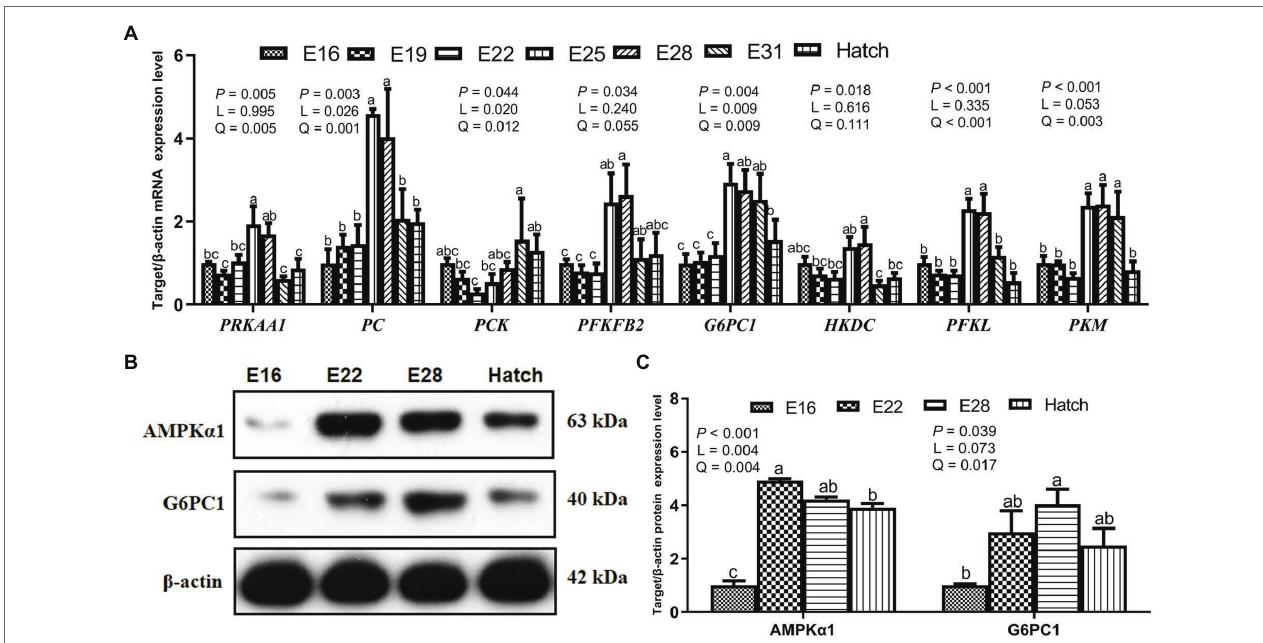
FIGURE 2 | Hepatic gene and protein expression related to glucose metabolism in the avian model. (A) Hepatic gene mRNA relative expression related to glucose metabolism in the avian model; (B,C) The expression of proteins related to glucose metabolism in the liver of avian embryos. PRKAA1 , protein kinase AMP-activated catalytic subunit alpha 1; PC , pyruvate carboxylase; PCK , phosphoenolpyruvate carboxykinase; PFKFB2 , 6-phosphofructo-2-kinase; G6PC1 , glucose-6- phosphatase; HKDC , hexokinase; PFKL , phosphofructokinase; PKM , pyruvate kinase M1/2; AMPK α 1, AMP-activated protein kinase alpha 1. Data are expressed as mean ± SEM, and bars with different lowercase letters indicated statistically significant differences (one-way ANOVA, p < 0.05). L, linear; Q,